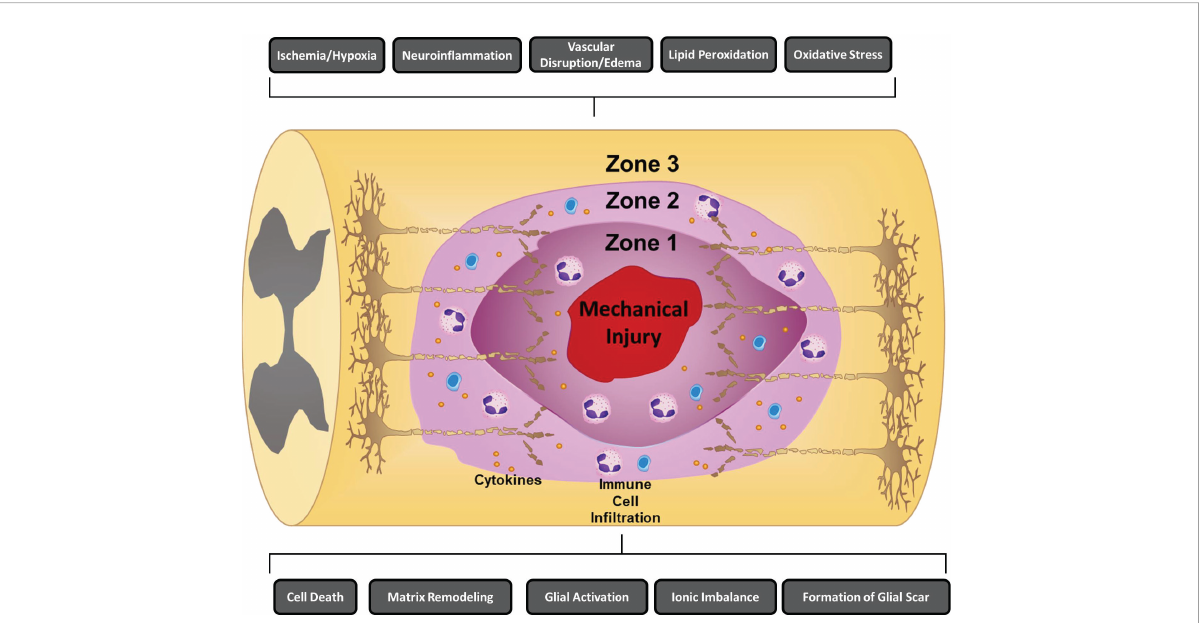
FIGURE 1 Mechanisms of secondary injury following traumatic spinal cord injury. Several key secondary mechanisms of injury that have been shown to contribute to the propagation of acute cell dysfunction and cell death including ischemia/hypoxia, neuroin fl ammation, vascular disruption/ edema, lipid peroxidation, oxidative stress, cell death, ionic imbalance, formation of a glial scar, glial activation, and matrix remodeling are depicted. Following SCI, three zones that differ in tissue quality form including: (1) Zone 1, which is mainly a product of the initial trauma and is de fi ned by regions of necrosis, in fl ammation, and cysts; (2) Zone 2, is characterized by regions of incomplete injury that are still accompanied by immune cell in fi ltration, axonal swelling, and Wallerian degeneration; and (3) Zone 3, which are histologically intact areas (15,